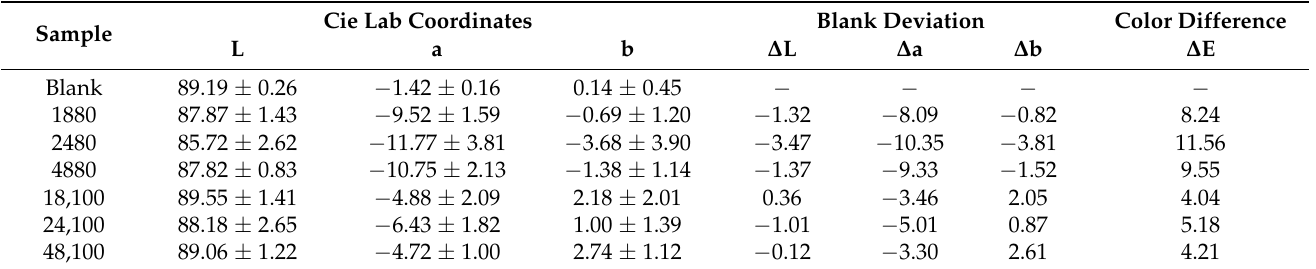
Table 2. CieLab coordinates results for all